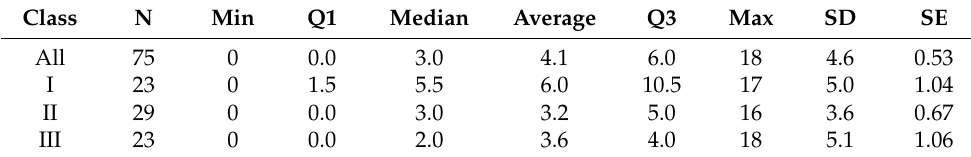
Table 3. Transversal condylar inclination (TCI) of the left temporomandibular joint (TMJ).